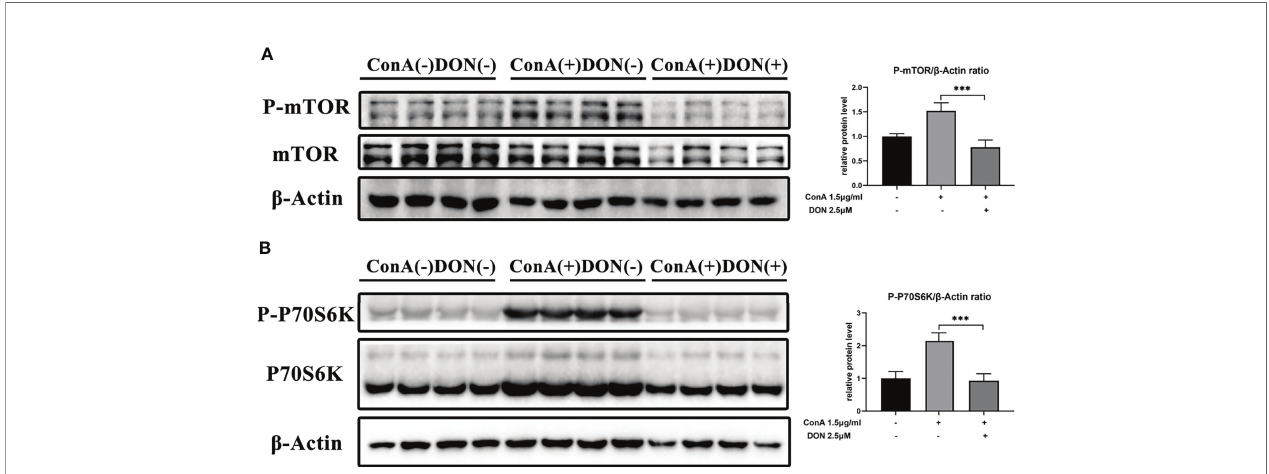
FIGURE 6 | The inhibition of activation and differentiation of T cells was mediated by mTOR signaling. Freshly separated spleen cells were stimulated with 1.5 mg/ml ConA with or without treating 2.5 m M DON, and cells were collected and proteins were extracted 24h after ConA stimulation. Western blotting was applied to analyze the levels of phosphorylated mTOR (A) and phosphorylated P70S6K (B) . Data were expressed as means ± SEM. *** P